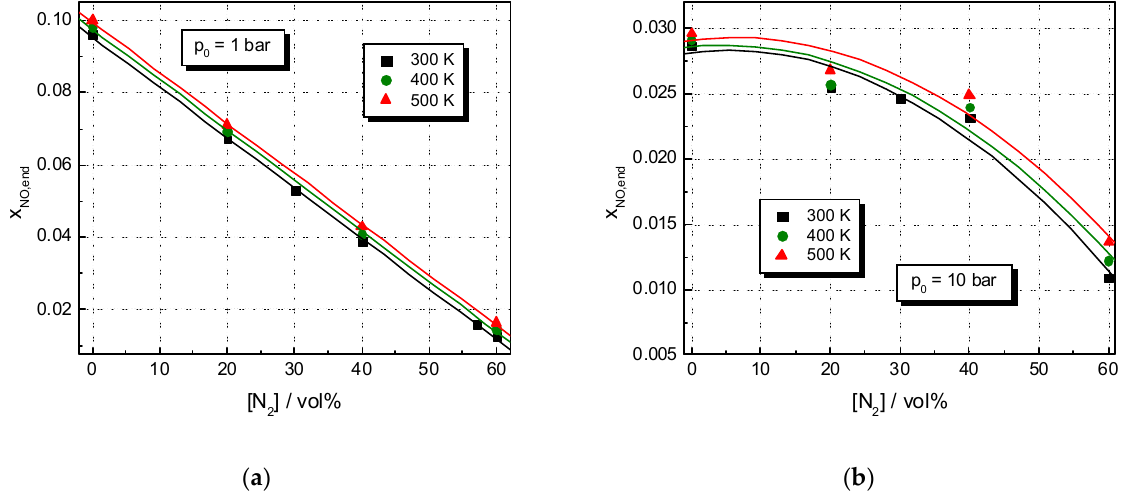
Figure 6. The influence of the added nitrogen on the end mass fraction of NO of stoichiometric H 2 –N 2 O–N 2 mixtures that were burning under various initial conditions: ( a ) mixtures at 1 bar and various initial temperatures; ( b ) mixtures at 10 bar and various initial temperatures.